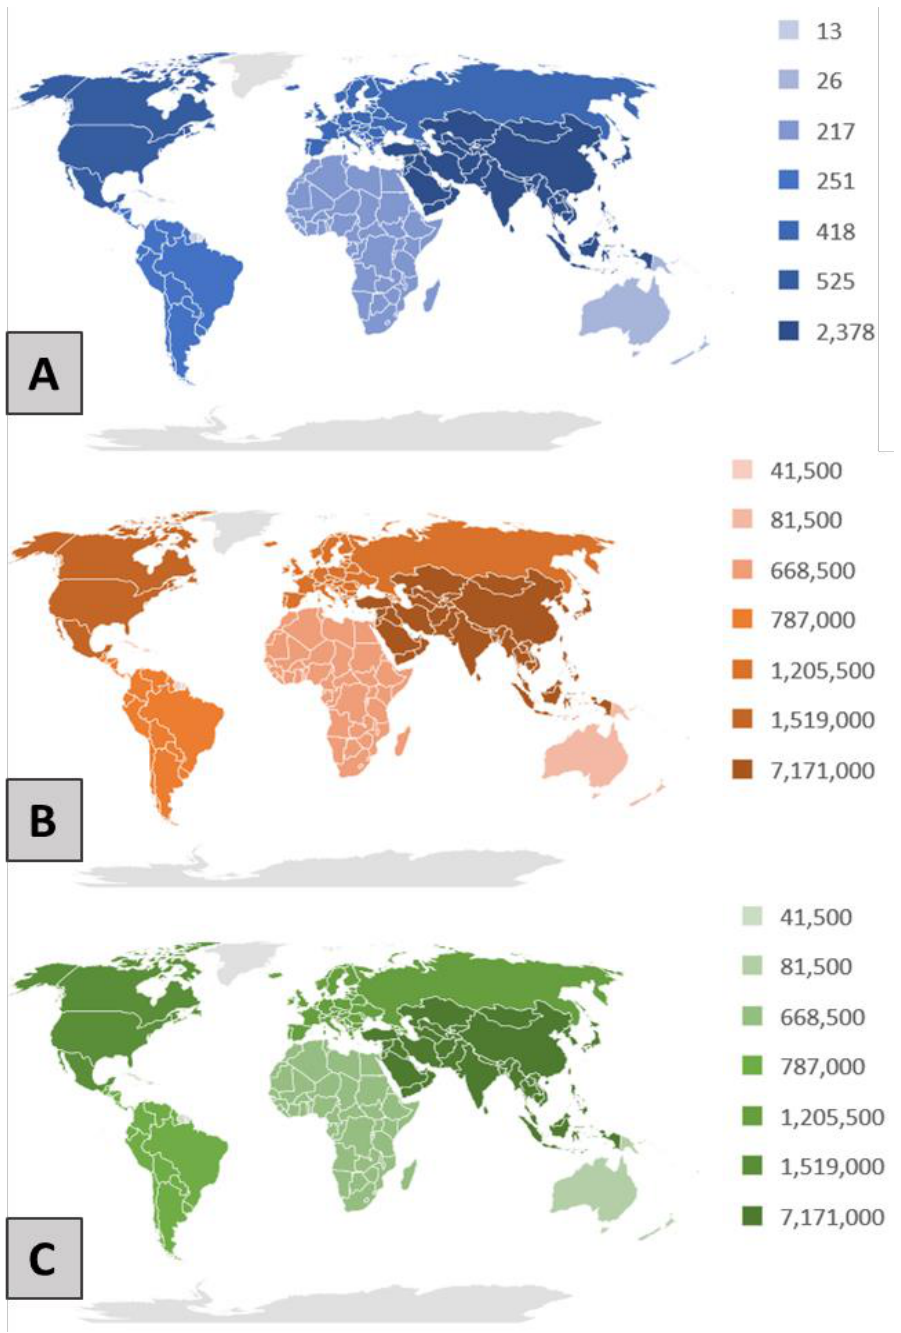
Figure 3. Analysis indicators related to water usage. ( A ) Total water withdrawals (km 3 /year), ( B ) energy requirements (kW/year) and ( C ) GHG emissions (t CO 2 e/year).